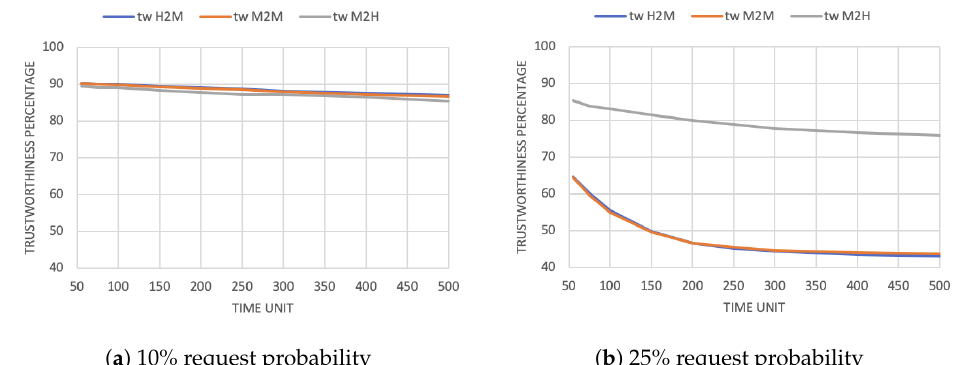
Figure 3. Average trustworthiness evaluation in the trustworthiness-based scenario.